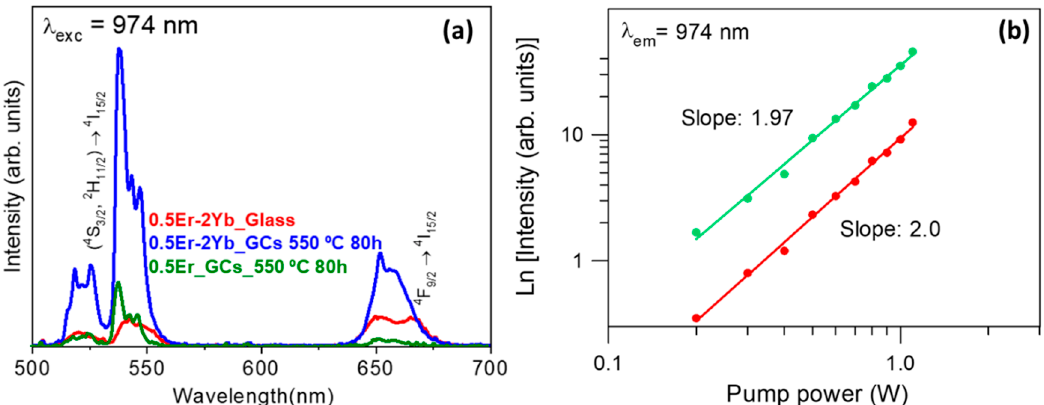
Figure 7. ( a ) Up-conversion emission spectra of 0.5 Er 3+ -doped and 0.5Er 3+ –2Yb 3+ -codoped 70Si7Gd glass and GCs treated at 550 °C for 80 h under excitation at 974 nm; ( b ) power dependence of UC emission intensity at 540 (green) and 650 (red) nm.